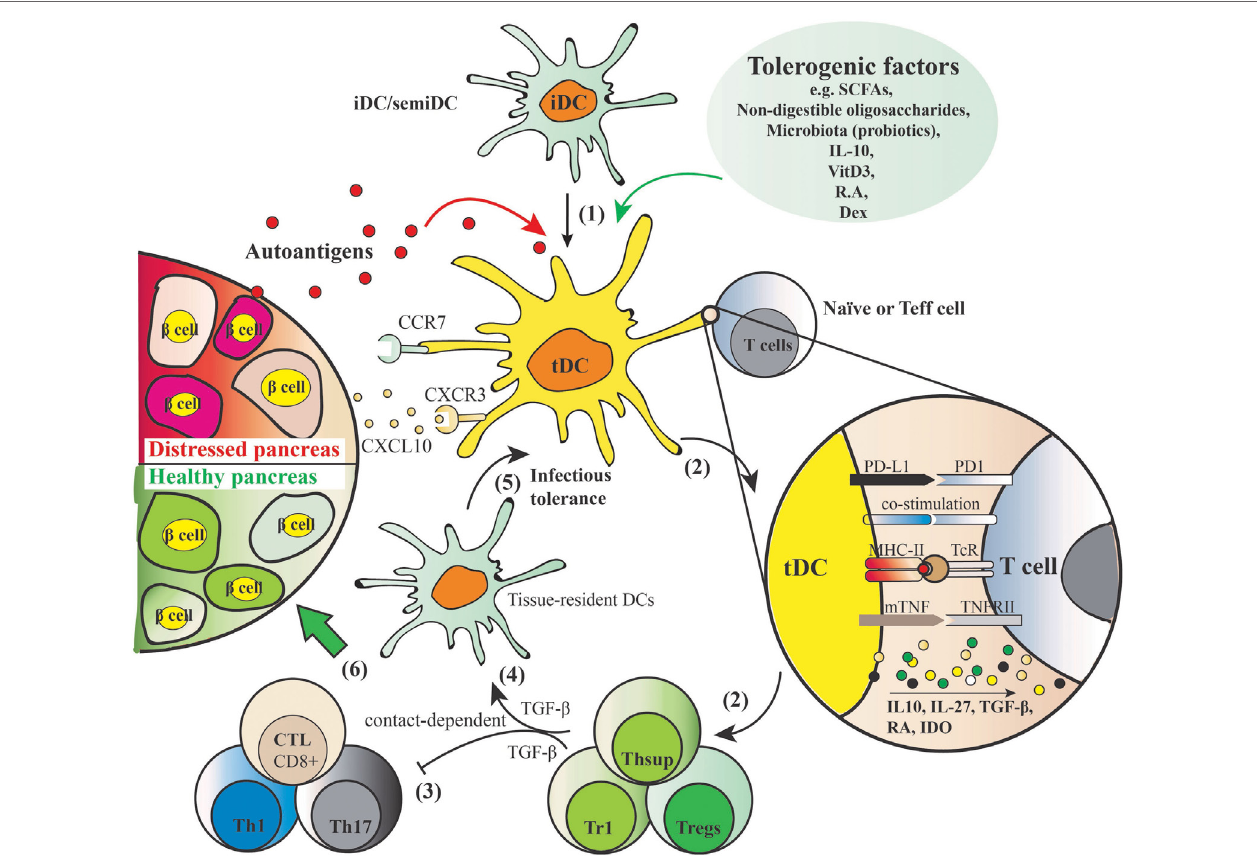
FiGURe 2 | Induction of autoantigen-specific tolerance by tolerogenic dendritic cells (tDCs) and mechanism of action. (1) Tolerogenic factors such as short-chain fatty acids, non-digestible oligosaccharides, microbiota, IL-10, vitamin D3, retinoic acid, and dexamethasone induce a tolerogenic phenotype of dendritic cells (DCs) with shared features include resistance of maturation, lowered levels of co-stimulatory markers (e.g., CD40, CD80, CD83, CD86), elevated levels of programmed death ligand 1 (PD-L1) [PD-L1–PD1 signaling induces apoptosis of effector Th1 and cytotoxic lymphocytes (CTL), and is crucial for acquisition of regulatory T cell (Treg) function] and membrane bound TNF, induction of anti-inflammatory cytokine profiles (low IL-12 and IL-6, IL-10, IL-27, and TGF- β ), and increased expression of migration markers such as CXCR3 and CCR7 that allows for migration to the lymphoid organs and inflammatory lesion in the pancreas producing CXCL10. (2) When these tDCs are pulsed with autoantigens and exposed to cognate naïve or effector T cells, they present processed autoantigens to the T cells to induce Tregs. (3) Natural or induced Tregs suppress the activation of autoreactive Th1/Th17 and cytotoxic CD8 + T cells in a cell contact–dependent manner. (4) In addition, inhibitory mediators such as TGF- β produced by the induced secondary T suppressor cells (Thsup) inhibit the activation of T effector cells. (5) Convert the tissue-resident DCs to tDCs through an “infectious tolerance” mechanism, thereby reinforcing the tolerogenic phenotype. This secondary systemic suppressive effect is cell contact independent. (6) These five mechanisms mediated by tDCs together contribute to the desired endpoint, namely, a healthy